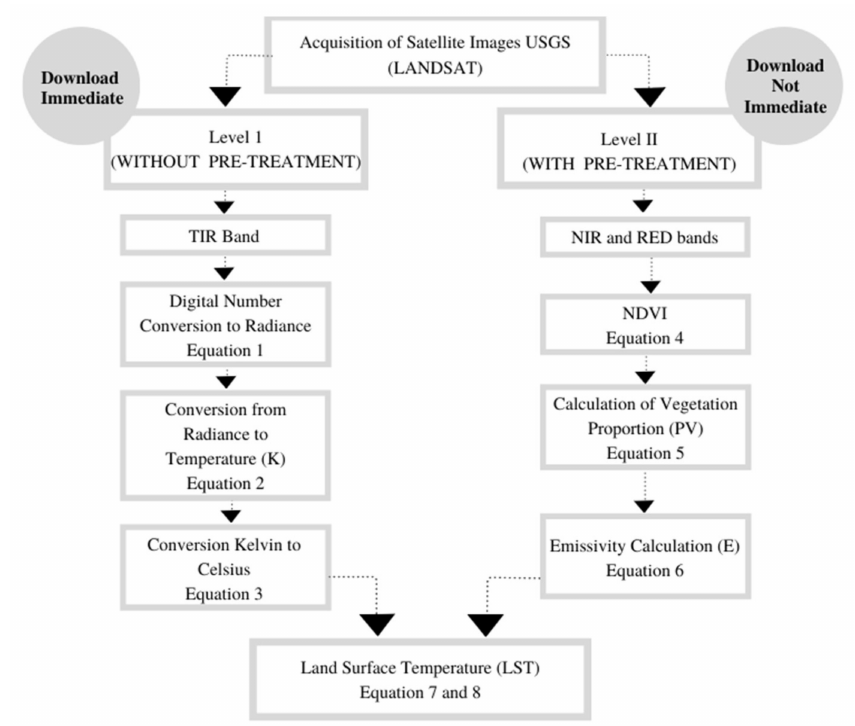
Figure 2. Steps for generating the LST